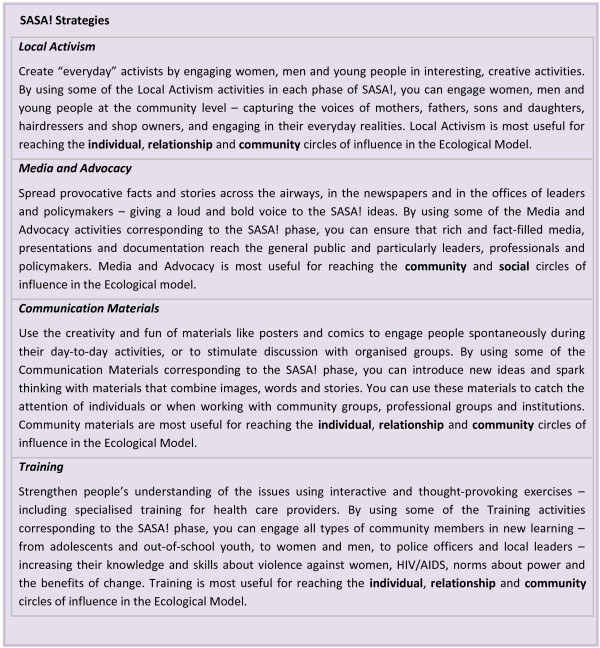
SASA! strategies.